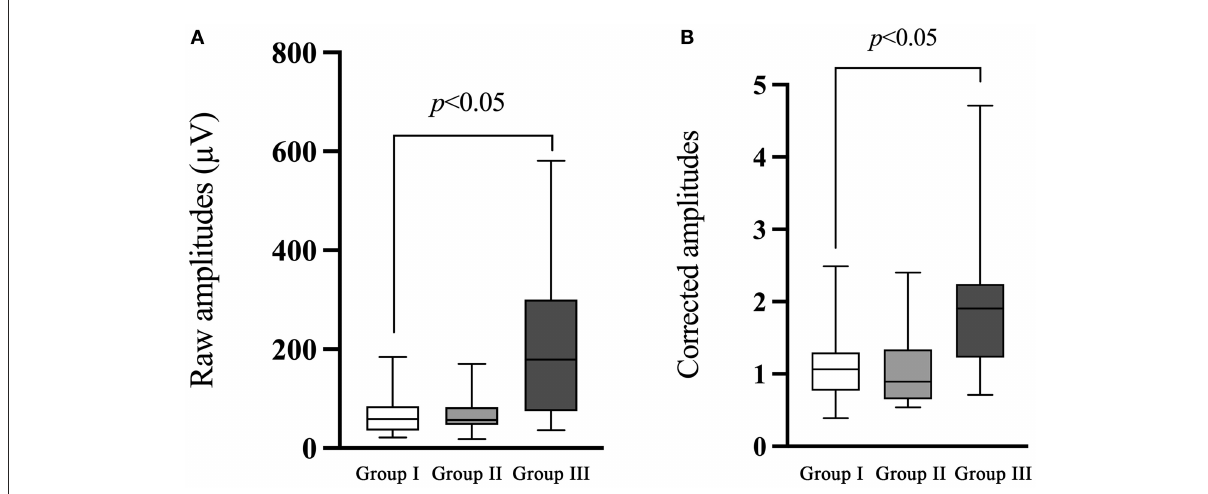
FIGURE4 Comparison of the raw and corrected amplitudes of ACS-cVEMP. (A) The comparison of the raw amplitude of ACS-cVEMP. (B) The comparison of the corrected amplitude of ACS-cVEMP. The white box plot represented group I ( n = 24 ears), light gray box plot represented group II ( n = 18 ears), dark gray box plot represented group III ( n = 40 ears). There was no significant difference in the raw or corrected amplitude between group I and group II. Group III had significantly larger raw and corrected amplitudes than that in group I. In this study, no parameter comparison was made between group II and group III. Group I: Normal hearing ears from infants; Group II: Sensorineural hearing loss ears from infants; Group III: Normal Hearing ears from adults.